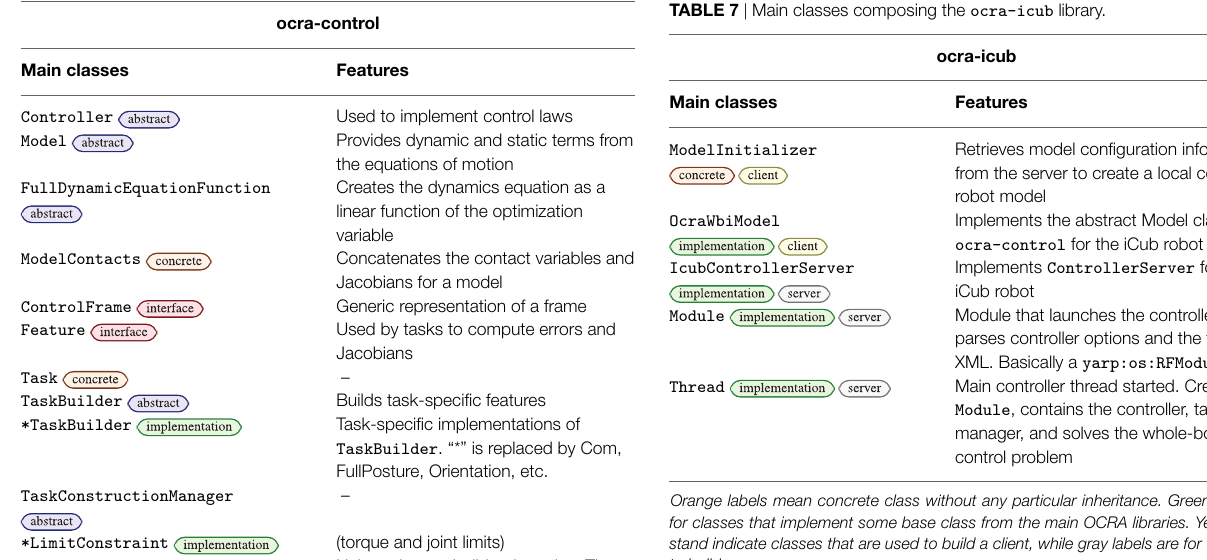
TABLE 5 | Main classes composing the ocra-control library.